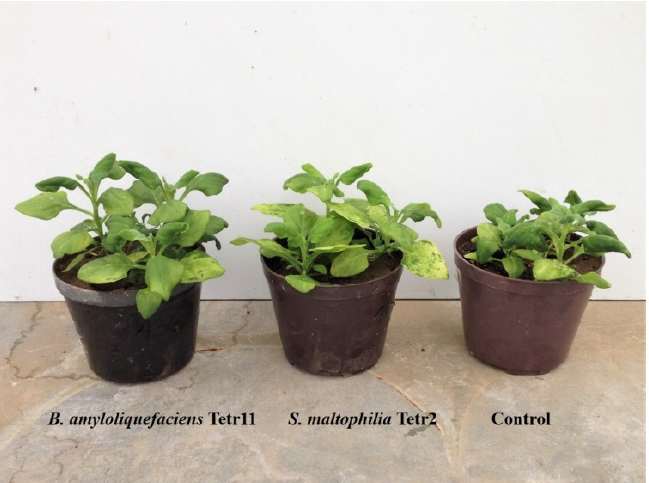
Figure 3. The effect of endophytic bacteria Bacillus amyloliquefaciens Tetr 11, and Stenotrophomonas maltophilia Tetr 2 on the growth of Tetragonia tetragonioides (Pall.) Kuntze. The plants were grown in a greenhouse for 30 days at 24 °C/16 °C (day/night).